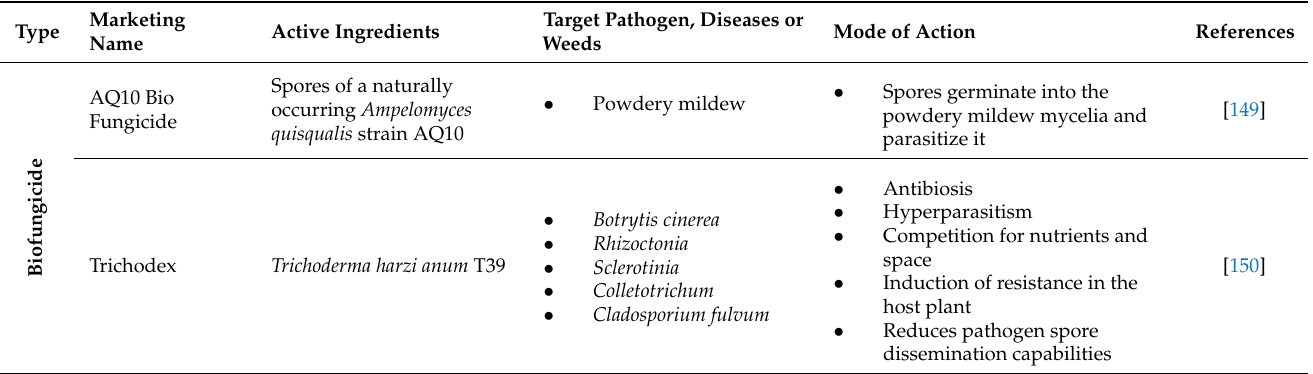
Table 4. Commercial biocontrol